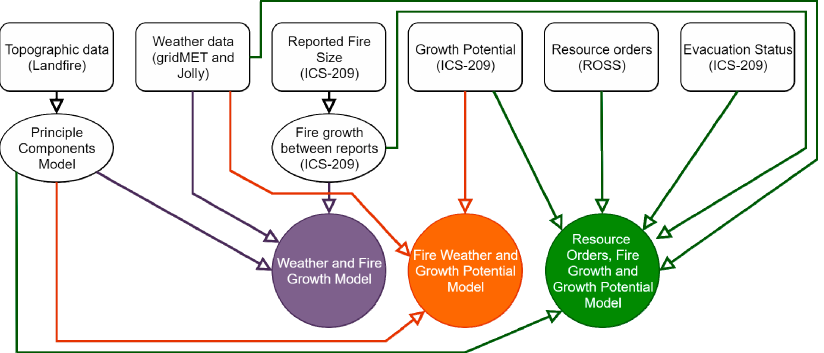
Figure 1. Data processing diagram to illustrate how key variables and data sources are integrated to produce the dataset used for analysis.